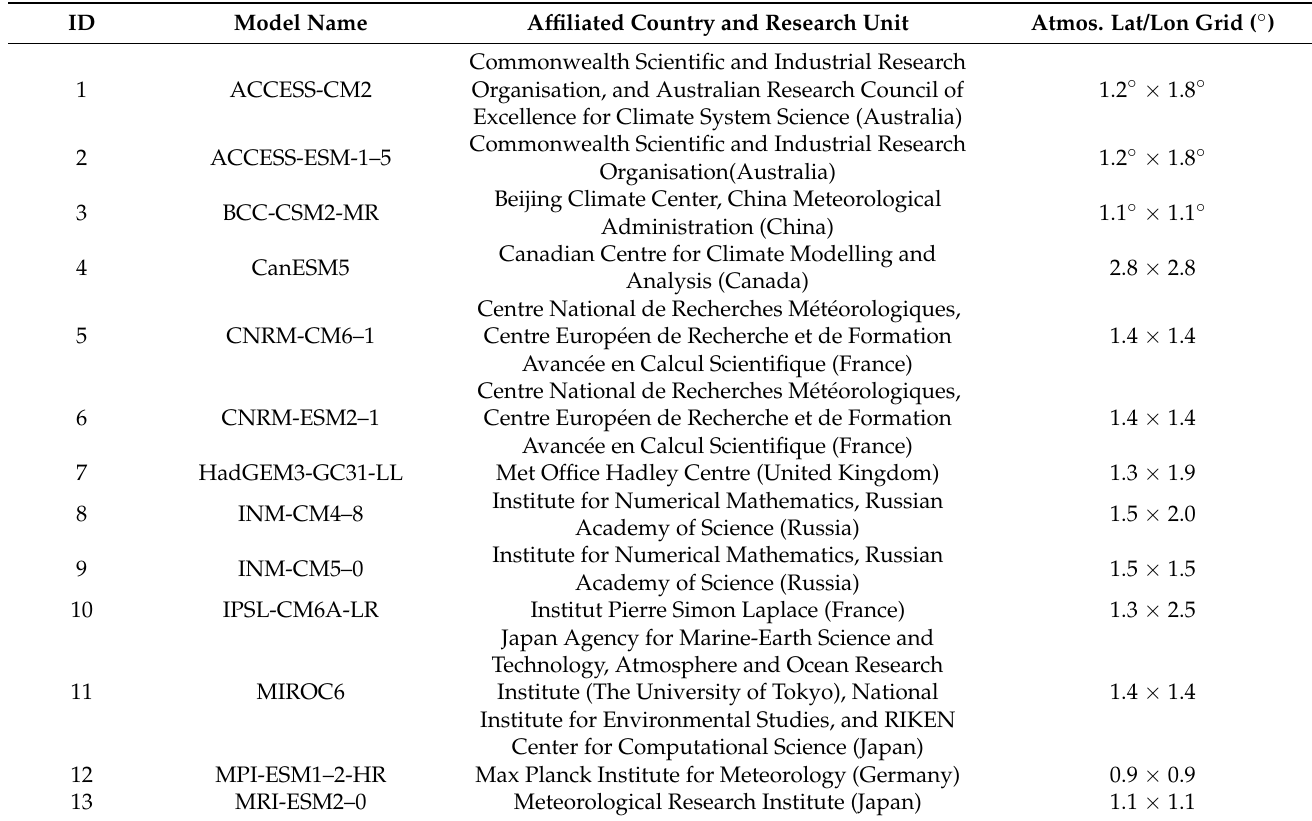
Table 1. Details of the CMIP6 models used in this